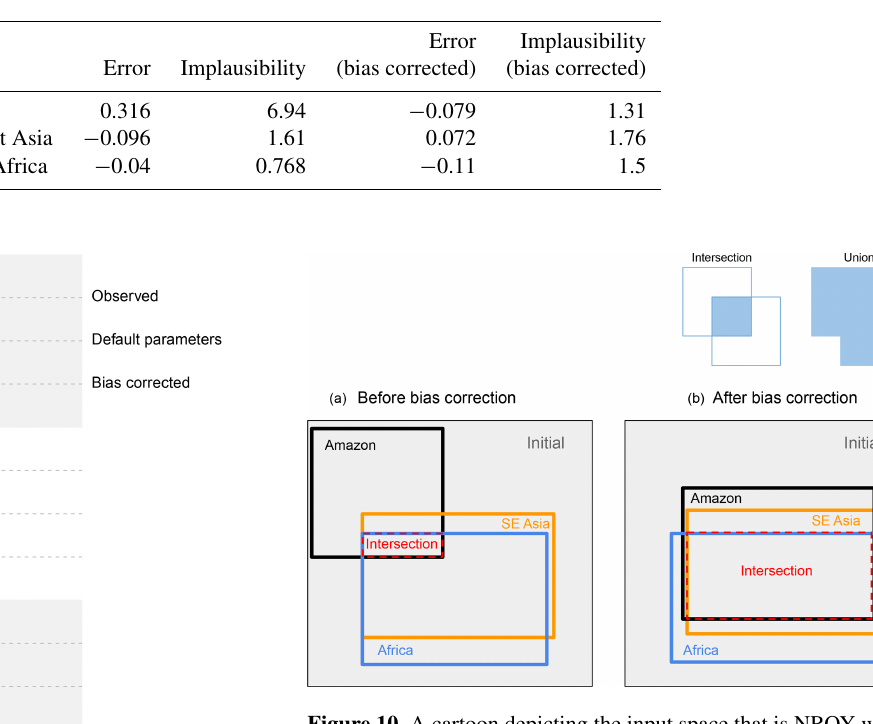
Figure 10. A cartoon depicting the input space that is NROY when the climate simulator output is compared to observations of the for- est fraction in the Amazon, Africa and southeast Asia before (a) and after (b) bias correction. We measure the “shared” space (the inter- section of NROY spaces for each forest) as a fraction of the union (the total space covered by all three forests) of the NROY spaces. The “initial” space represents the total parameter space covered by the